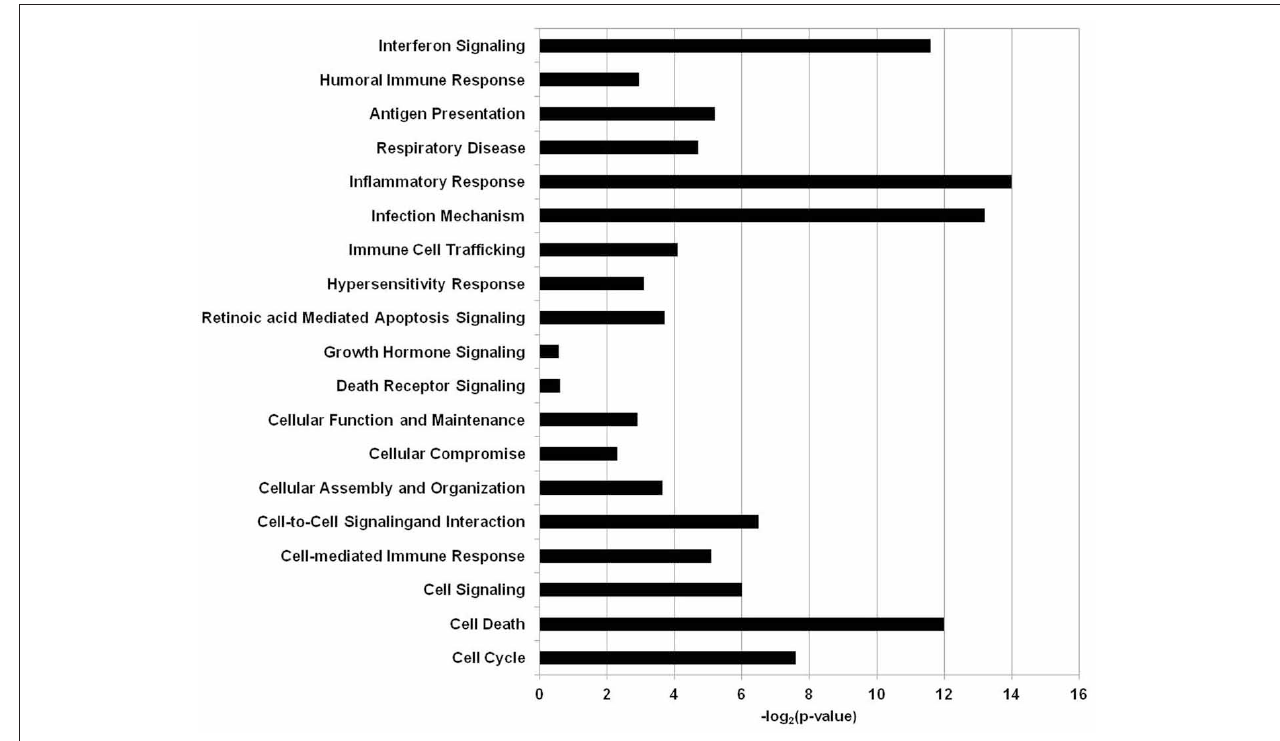
FIGURE 2 | Biological functions and processes in human airway cells exposed to Alternaria alternata spores. The x-axis depicts the biological processes and y-axis is the − log ( p -value) as produced by IPA